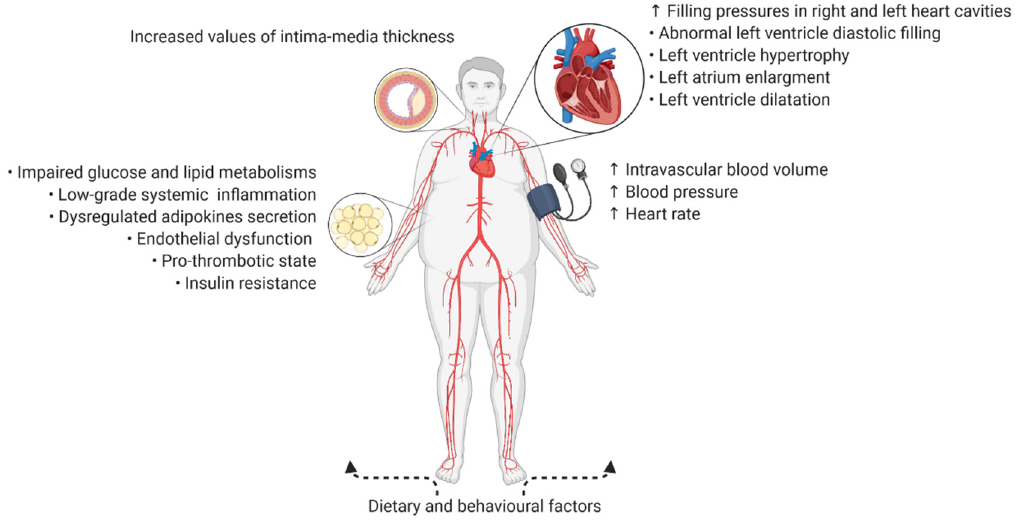
Figure 1. Indirect and direct ways in which obesity increases the cardiovascular risk. ↑ —increased. In the clinical practice, atherosclerosis can be diagnosed by means of several